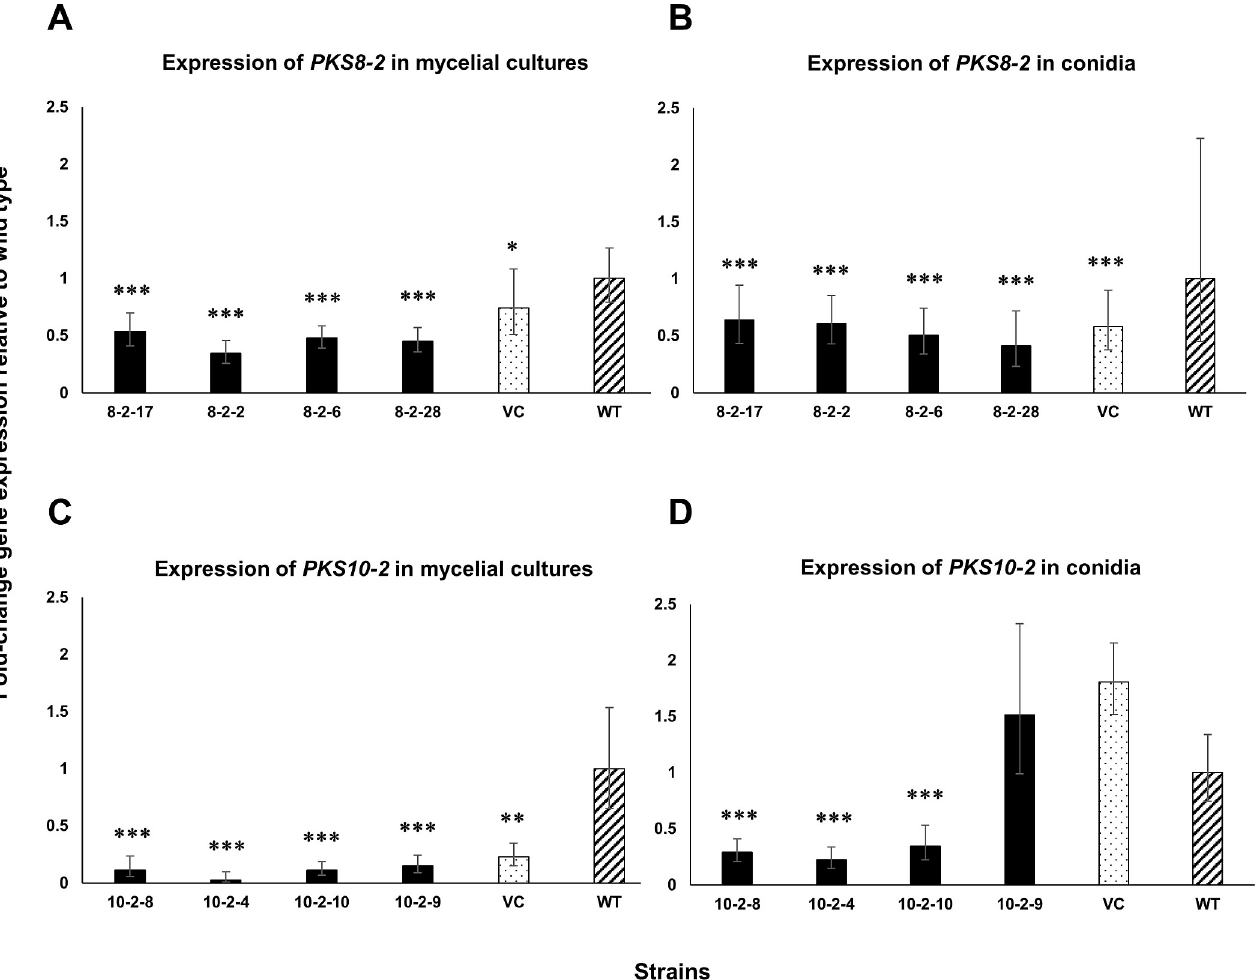
Fig 7. PKS gene expression in silencing transformants, vector control, and wild type. A) Expression of PKS8-2 from mycelial cultures harvested from four- week-old fungal cultures grown on banana leaf—Murashige and Skoog agar. B) Expression of PKS8-2 in conidia harvested from one-week-old mycelial cultures grown on modified V8 medium. C) Expression of PKS10-2 from mycelial cultures harvested from four-week-old fungal cultures grown on banana leaf— Murashige and Skoog agar. D) Expression of PKS10-2 in conidia harvested from one-week-old mycelial cultures grown on modified V8 medium. Controls included the vector control (VC) (dotted bars) and wild type (WT) (hatched bars). Samples were normalized to the actin gene for the PKS8-2 expression and the ubiquitin gene for the PKS10-2 expression. Fold-change gene expression in the transformed lines is shown relative to expression in the wild type isolate 10CR1- 24. Statistical significance was assessed using one-way ANOVA combined with Dunnett’s multiple comparison analysis using the normalized transcript of 10CR1-24 as the control group. Differences in gene transcript levels considered statistically significant are denoted by asterisks ( � P < 0.05, �� P < 0.01, and ��� P < 0.001). Error bars indicate standard error from three biological replicates for mycelial and conidial expression. Each biological replicate was tested with three technical